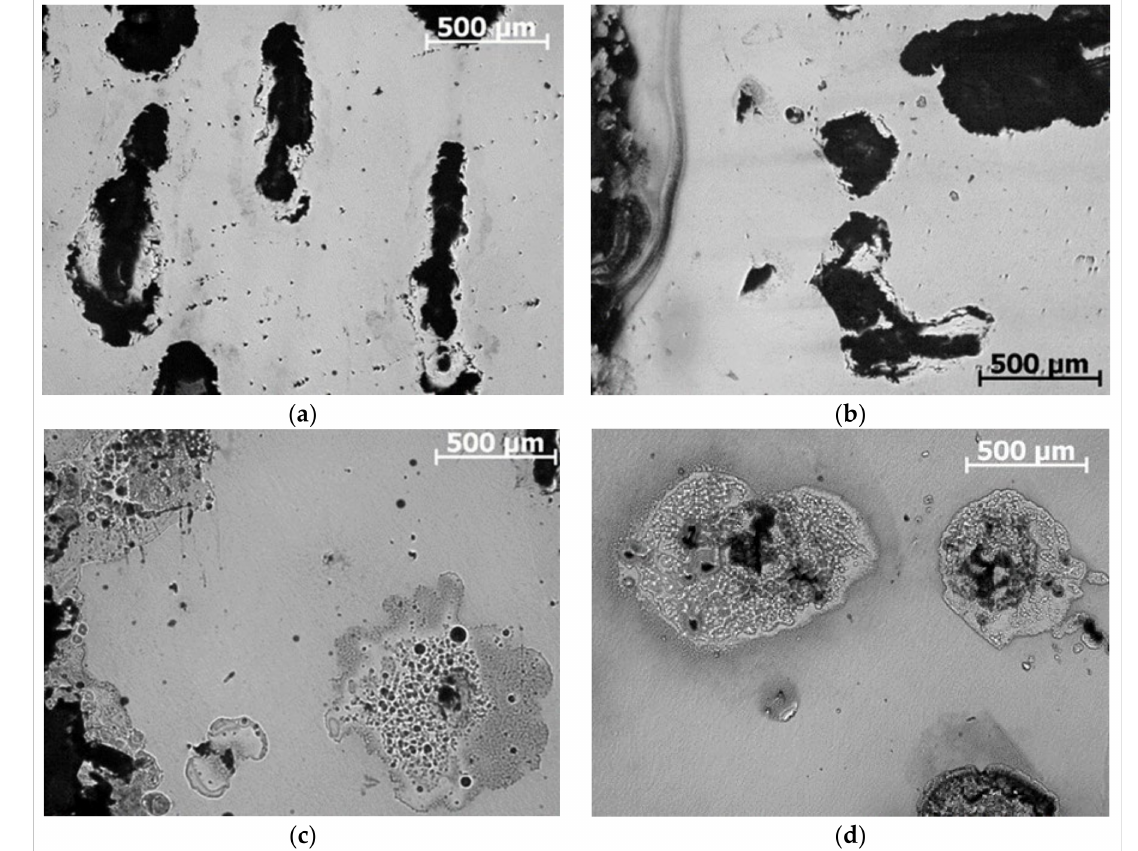
Figure 11. Analysis of micrographs after EIS measurements: ( a ) substrate; ( b ) 2-layer sample; ( c ) 4-layer sample; ( d ) 6-layer